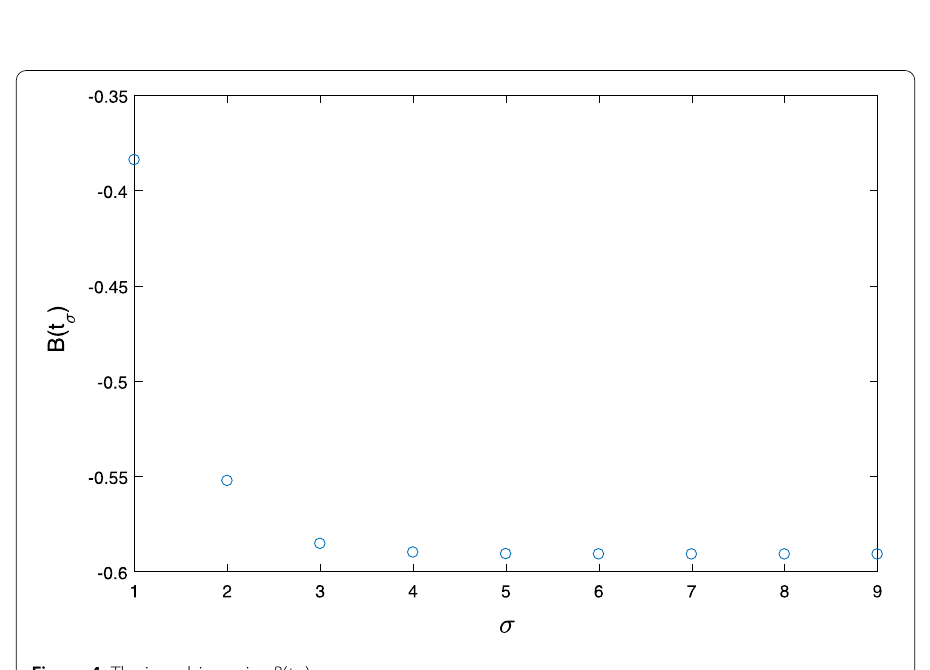
Figure 4 The impulsive gains B ( t σ ) versus